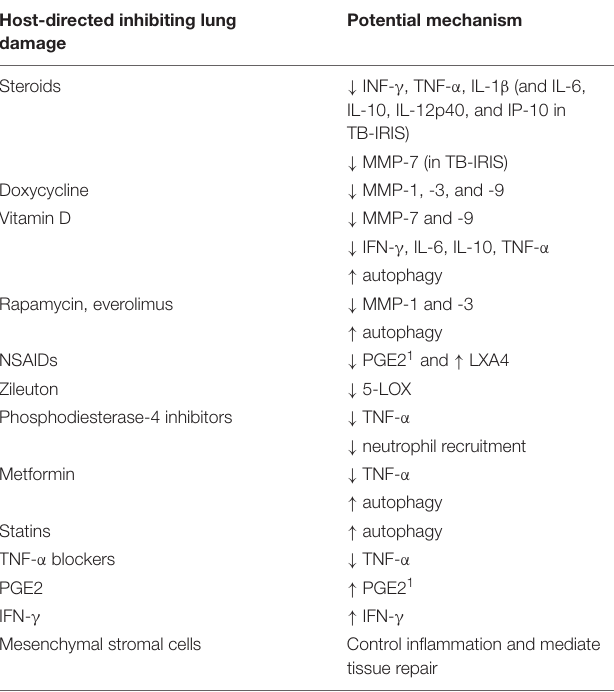
TABLE 1 | Host-directed therapies potentially inhibiting lung damage and/or promoting lung repair. Host-directed inhibiting lung